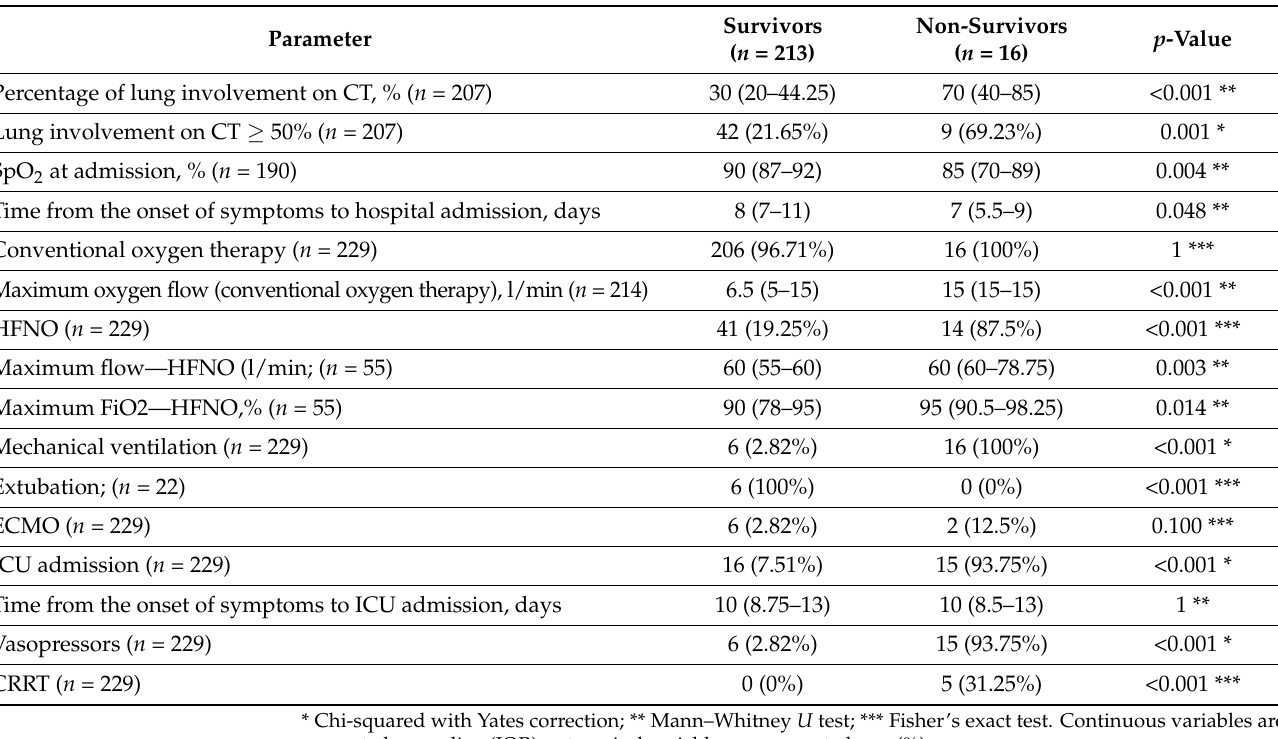
Table 6. Comparison of patients’ laboratory parameters (as continuous variables) between survivors and